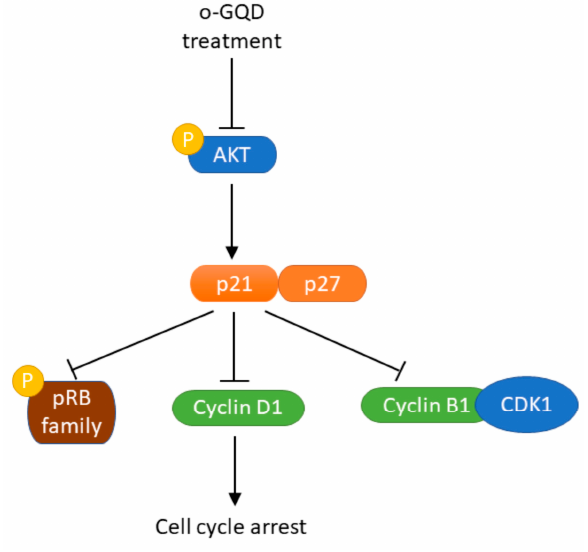
Figure 8. Schematic showing how o-GQD affected breast cancer cell signaling and triggered cell cycle arrest and apoptosis.